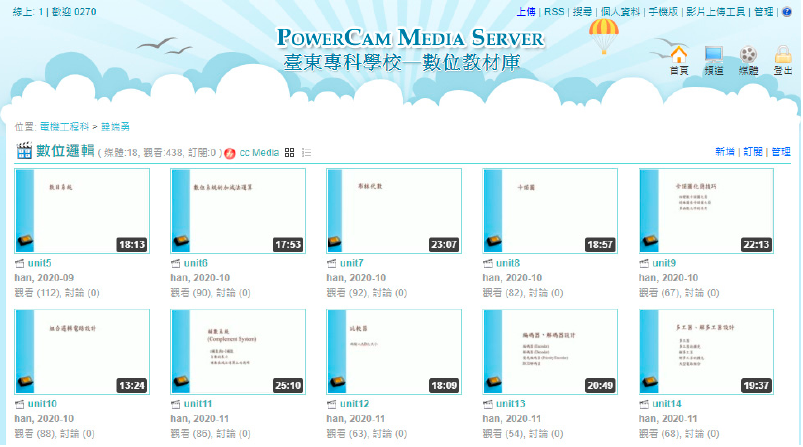
Figure 2. The homepage of the digital logic lecture videos stored in the E-media cloud of a junior college in southeastern Taiwan.